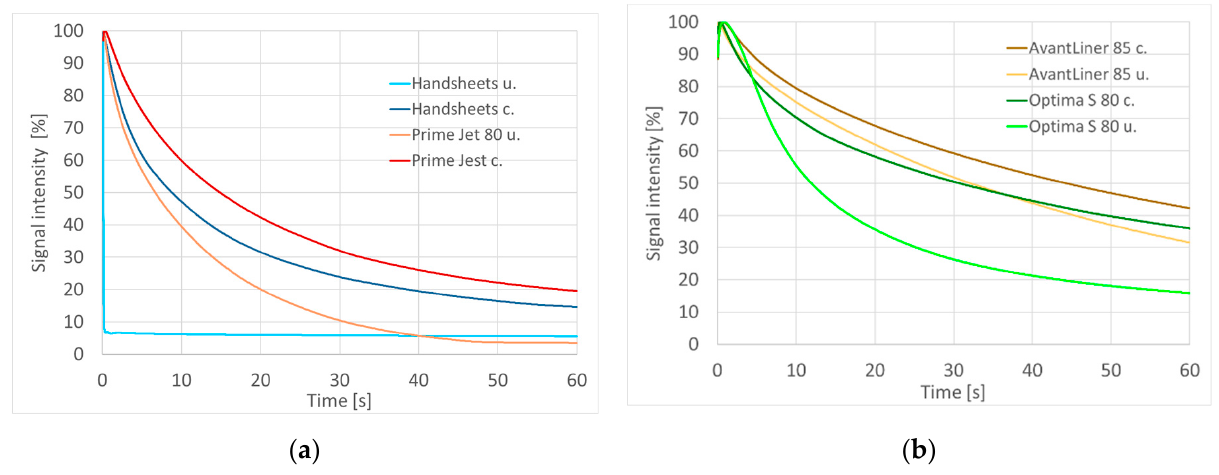
Figure 4. Water penetration dynamics (PDA) plots for ( a ) handsheets and Prime Jet 80, ( b ) AvantLiner 85 and Optima S 80 samples (u.—uncoated, c.—coated).